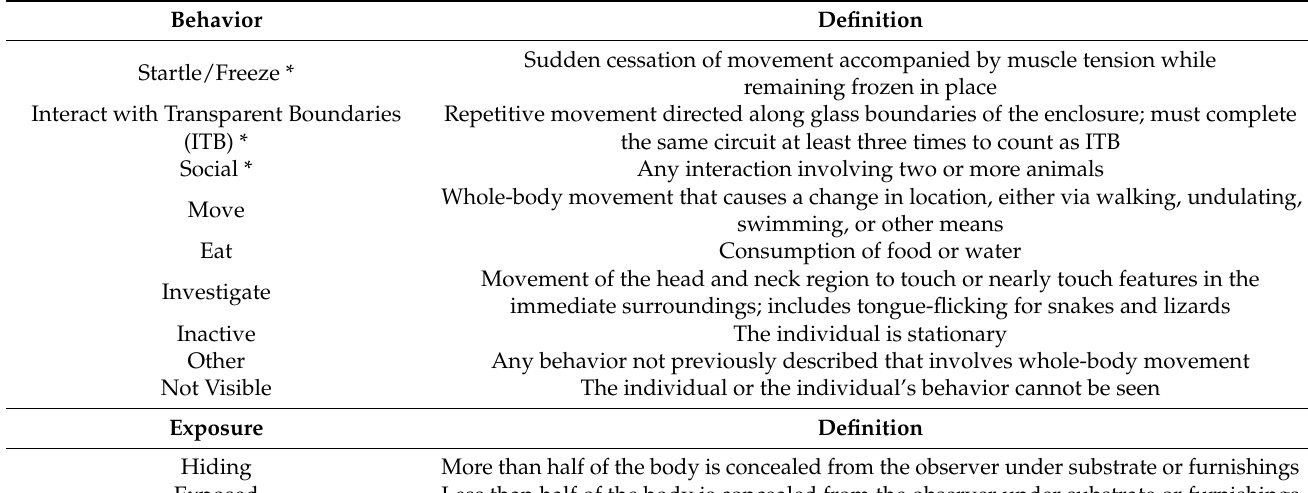
Table 4. Behavioral ethogram modified from Rose et al. [36] and Spain et al. [37]. All behaviors were included in scan sampling, and behaviors marked with an asterisk (*) were also recorded using all-occurrence